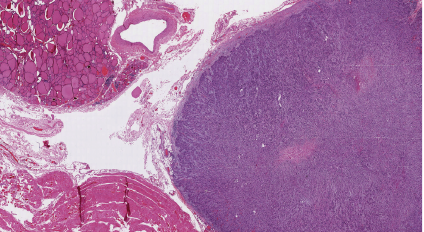
Figure 2: Tissue sample. A 1.4cm irregularly shaped encapsulated nodular lesion in the inferior pole of the left thyroid lobe which did not depend on the thyroid parenchyma.